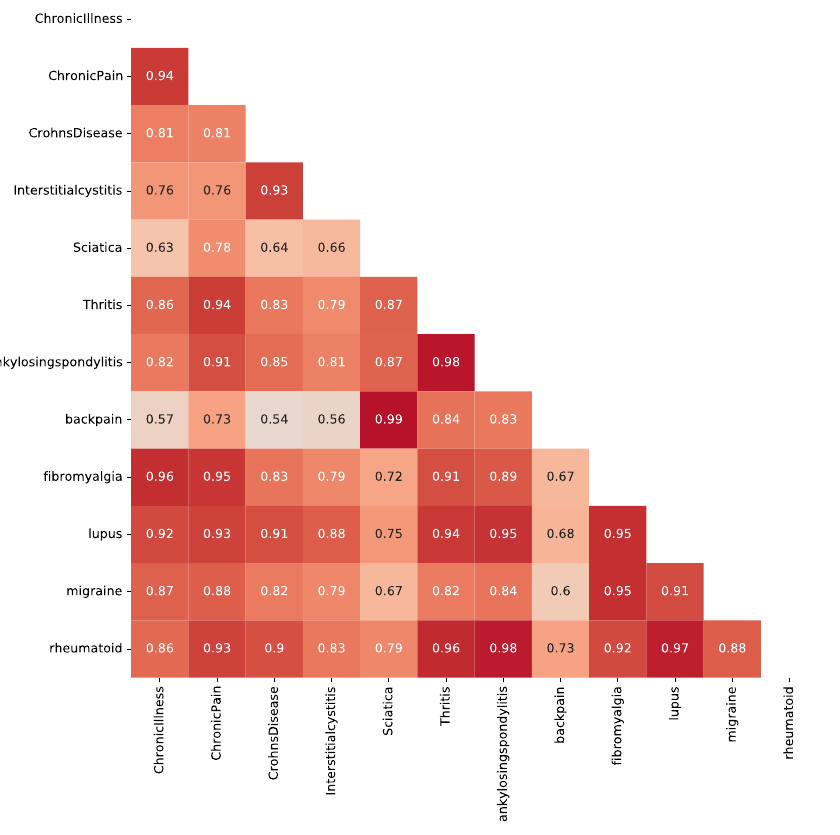
Figure A2. Similarity heatmap between subreddit centroids. Annotations represent the similarity between each pair of subreddits.